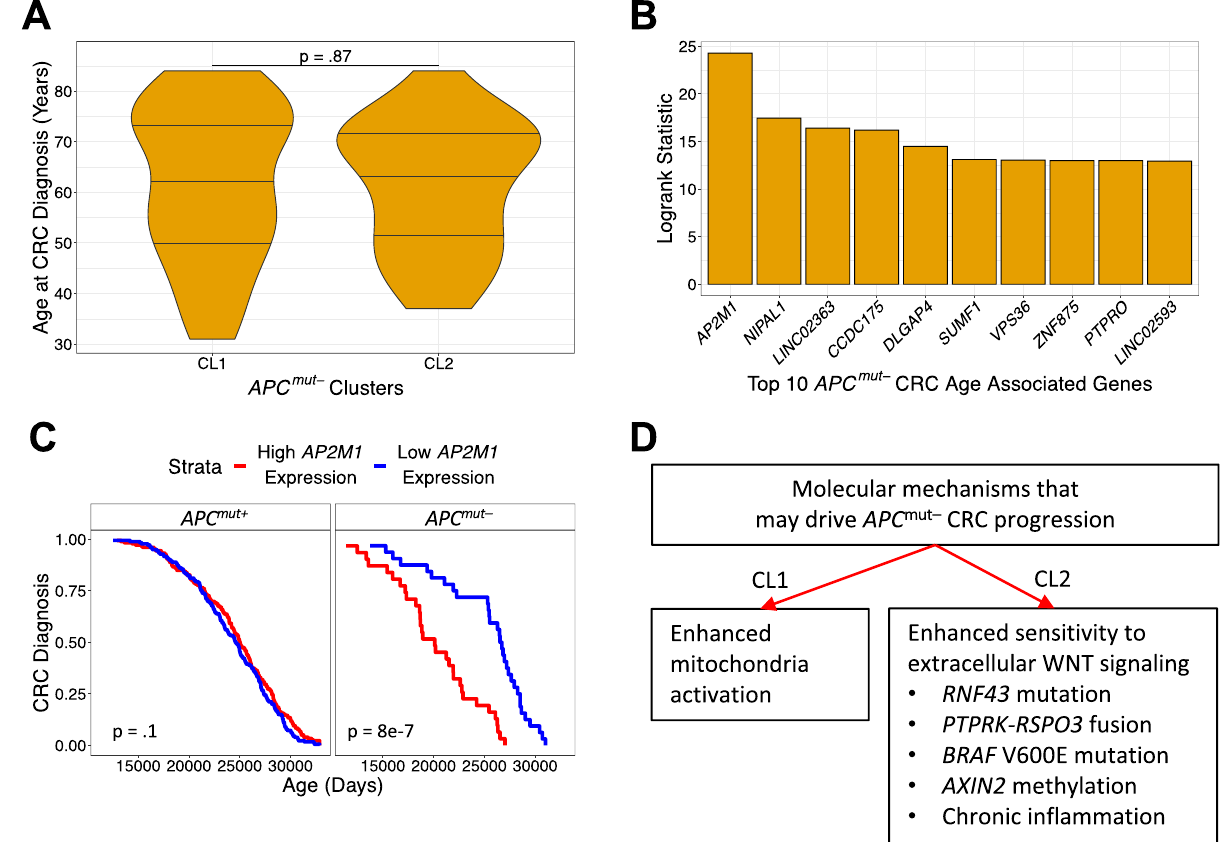
Figure 5. AP2M1 gene expression associated with earlier-onset in APC mut– CRCs. ( A ) A comparison of age between APC mut– clusters identified from Fig. 2D. A two-sample t-test with a two-tailed p-value was used to determine statistical significance. ( B ) Top 10 statistically significant genes based on a logrank test whose median gene expression best separates age of CRC diagnosis of APC mut– CRCs from the TCGA dataset. ( C ) Kaplan–Meier plot representing association between the age at CRC diagnosis and median separation of AP2M1 expression in APC mut– and APC mut + CRCs from the TCGA dataset. ( D ) Flowchart of two molecular mechanisms that may be involved in the development of APC mut–